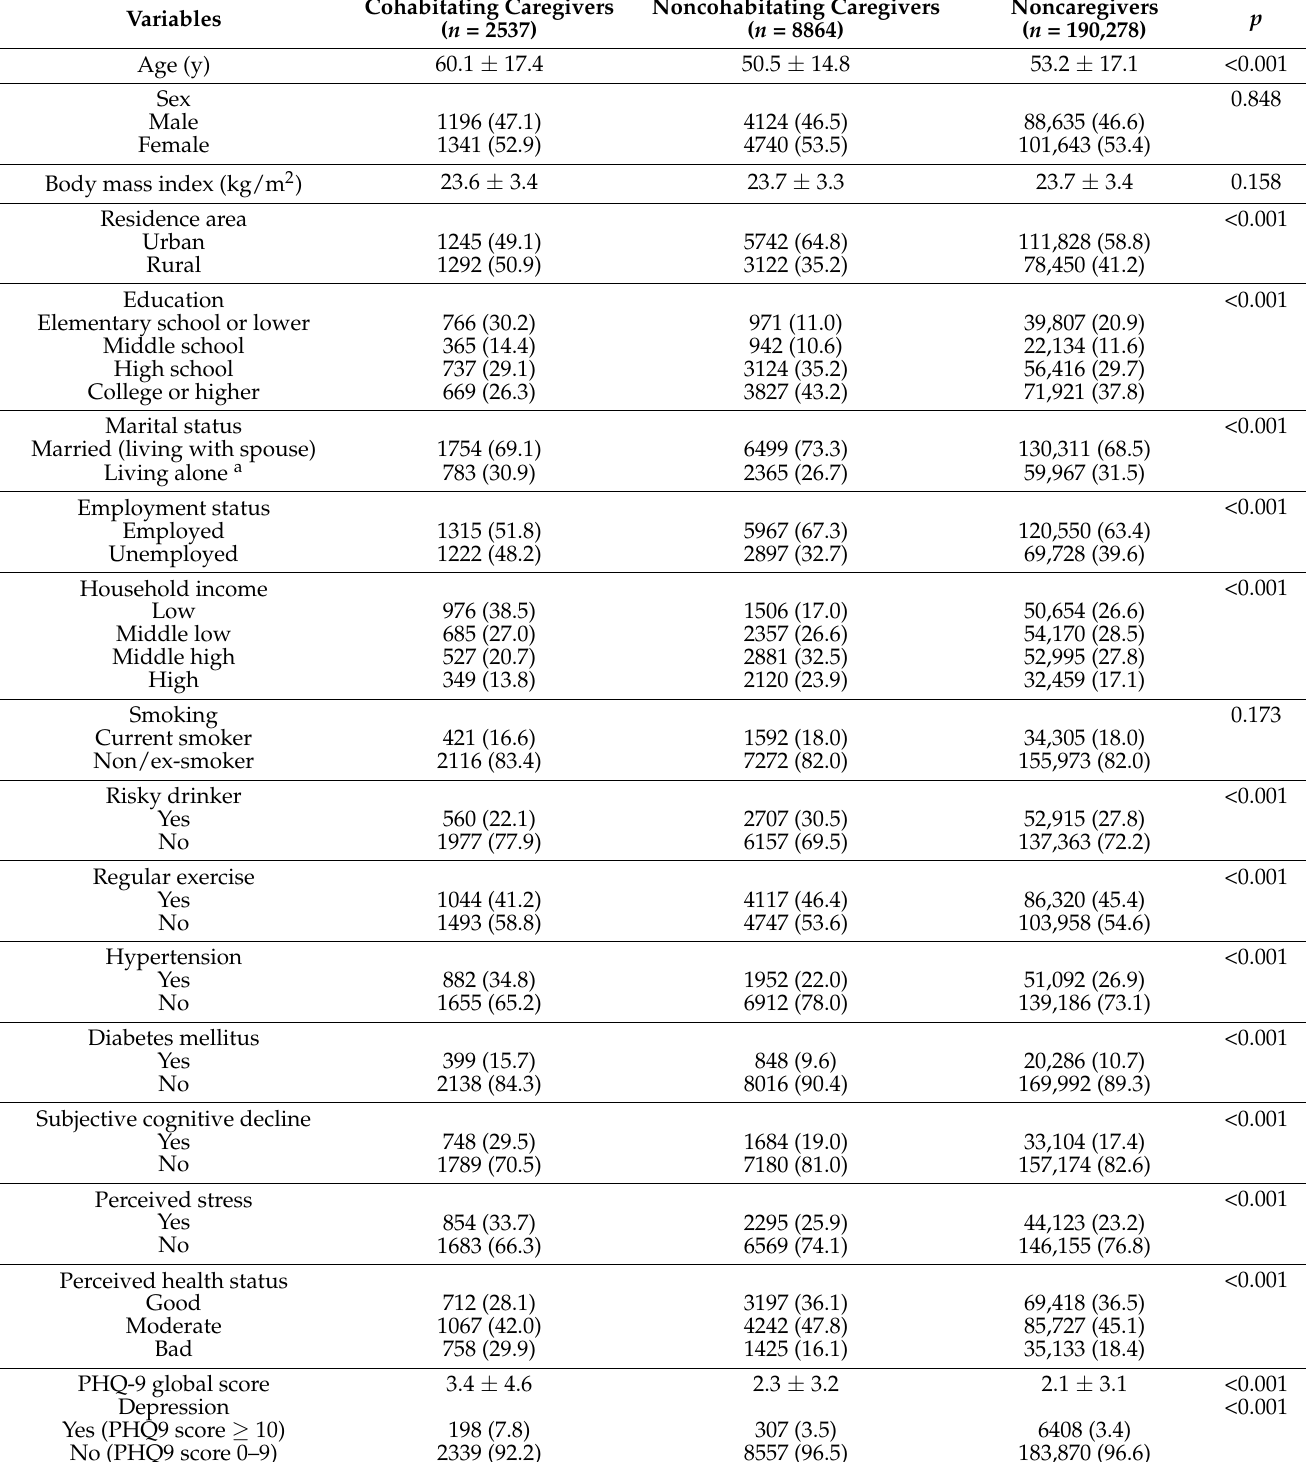
Table 1. Baseline characteristics of the cohabitating caregivers, noncohabitating caregivers, and